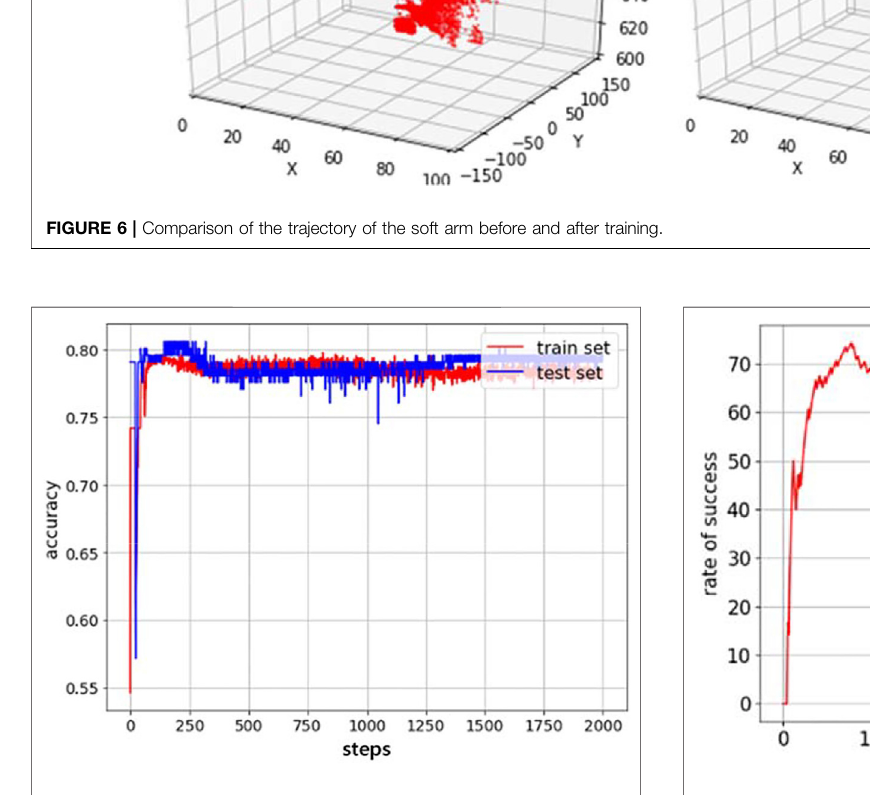
FIGURE 7 | Accuracy of train set and test set of the trajectory of the soft arm.